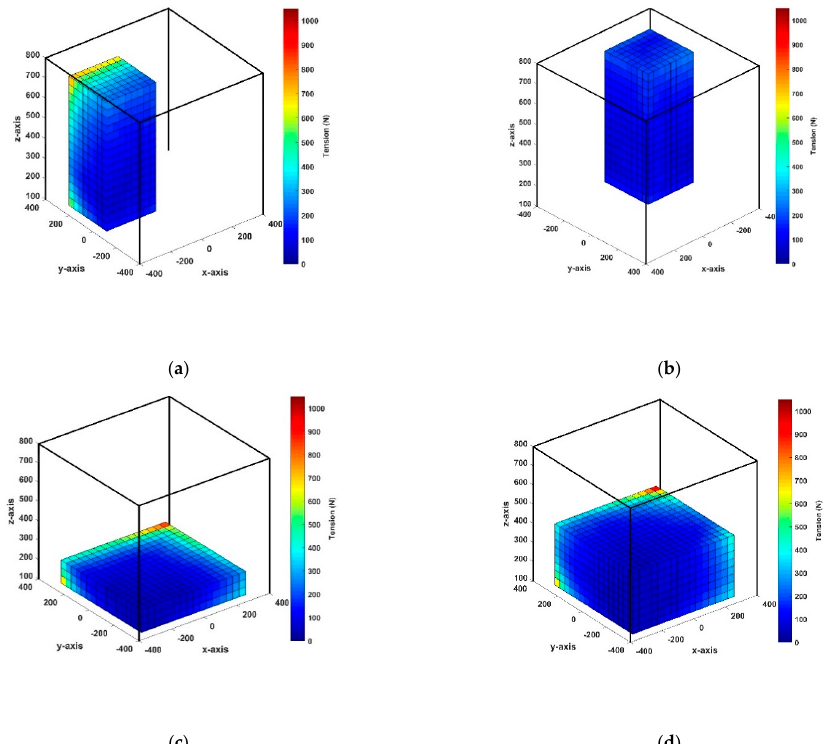
Figure 9. Quarter section of overall workspace simulation at the acceleration of 100 m/s 2 : ( a ) quarter section of X–direction; ( b ) quarter section of Y–direction; ( c ) section view of Z = 0.2 m; ( d ) section view of Z = 0.4 m.